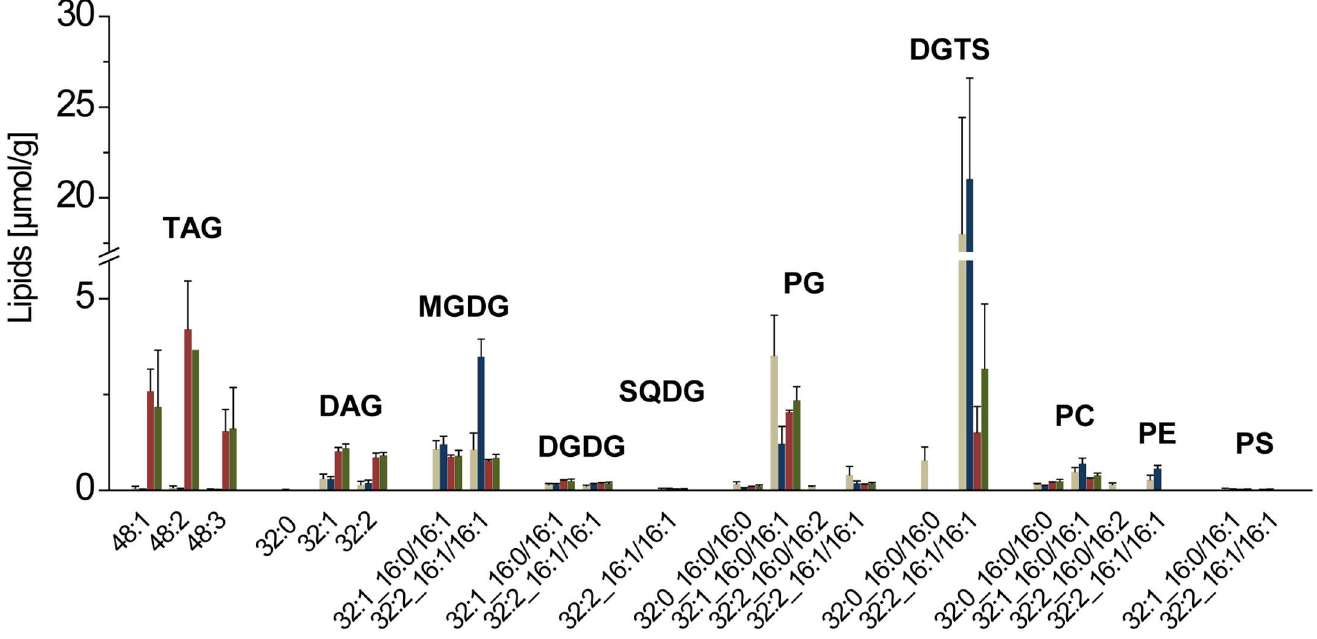
Fig 3. Main molecular lipid species that may be relevant for TAG synthesis. The diagrams show the comparison of day 0 (beige) and the last day of the growth kinetic of growth under replete conditions(blue), N-depletionwith normal light (red) and N-depletion with high light (green). Data are mean values of 3 biologicalreplicates, for the comprised time point 0d, 9 biologicalreplicateswere used. Error bars indicate standard